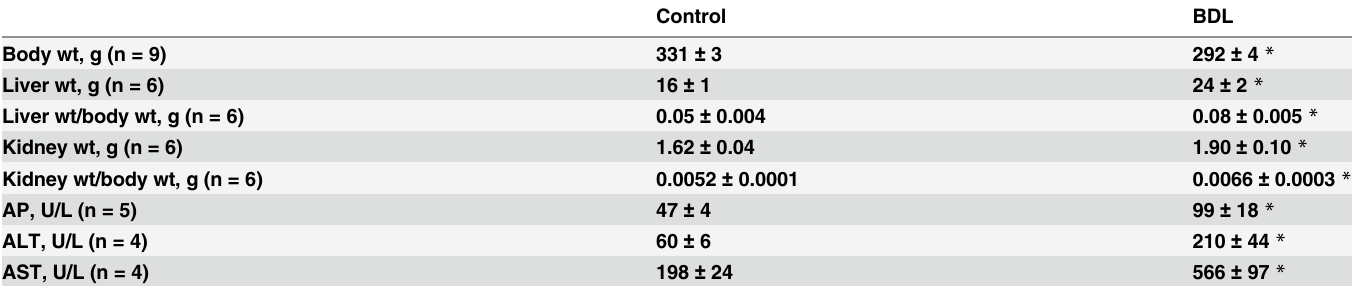
Table 1. Body and organ weights, organ weight-to-body weight ratio, and liver function parameters in control and bile duct ligation (BDL) experi- mental groups. Control